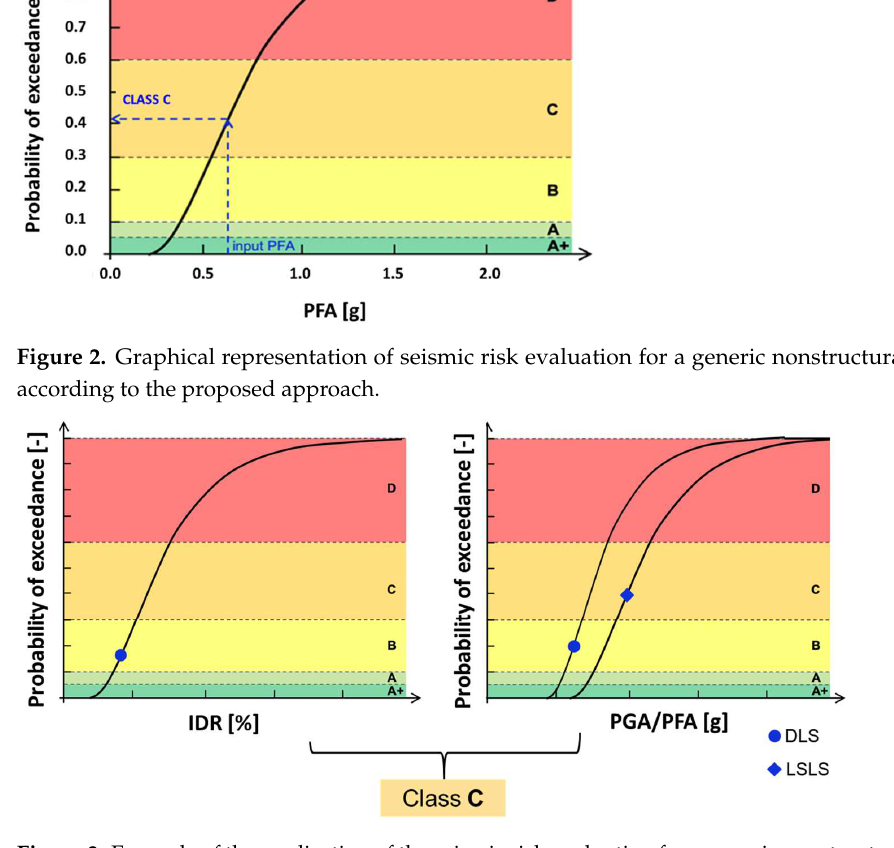
Figure 3. Example of the application of the seismic risk evaluation for a generic nonstructural element, in case of more than one fragility curve. in case of more than one fragility